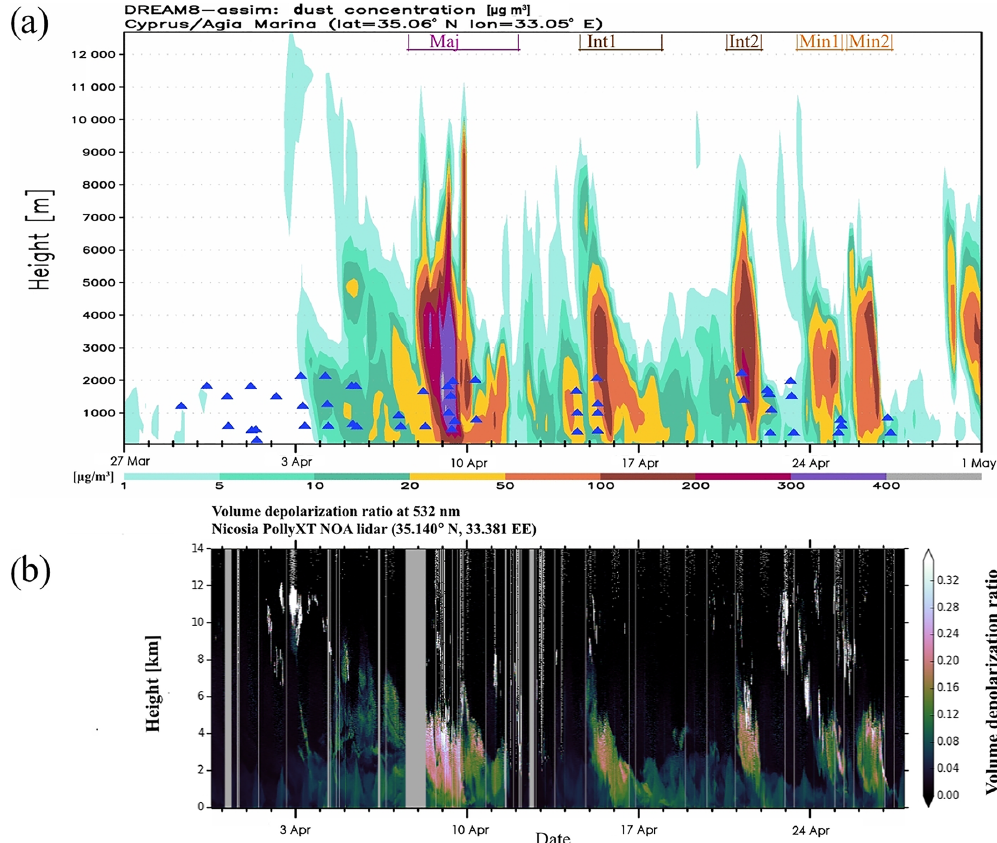
Figure 8. (a) Time series of dust mass concentration vs. altitude predicted by DREAM for the UAS airfield site. Episodes of mineral dust are categorized as major (Maj DE ), intermediate (Int DE1 , Int DE2 ), or minor (Min DE1 , Min DE2 ) dust events; see text. Blue triangles indicate UAS flights with INP sampling. (b) Time series of volume depolarization ratio at 532nm vs. height obtained from PollyXT lidar in